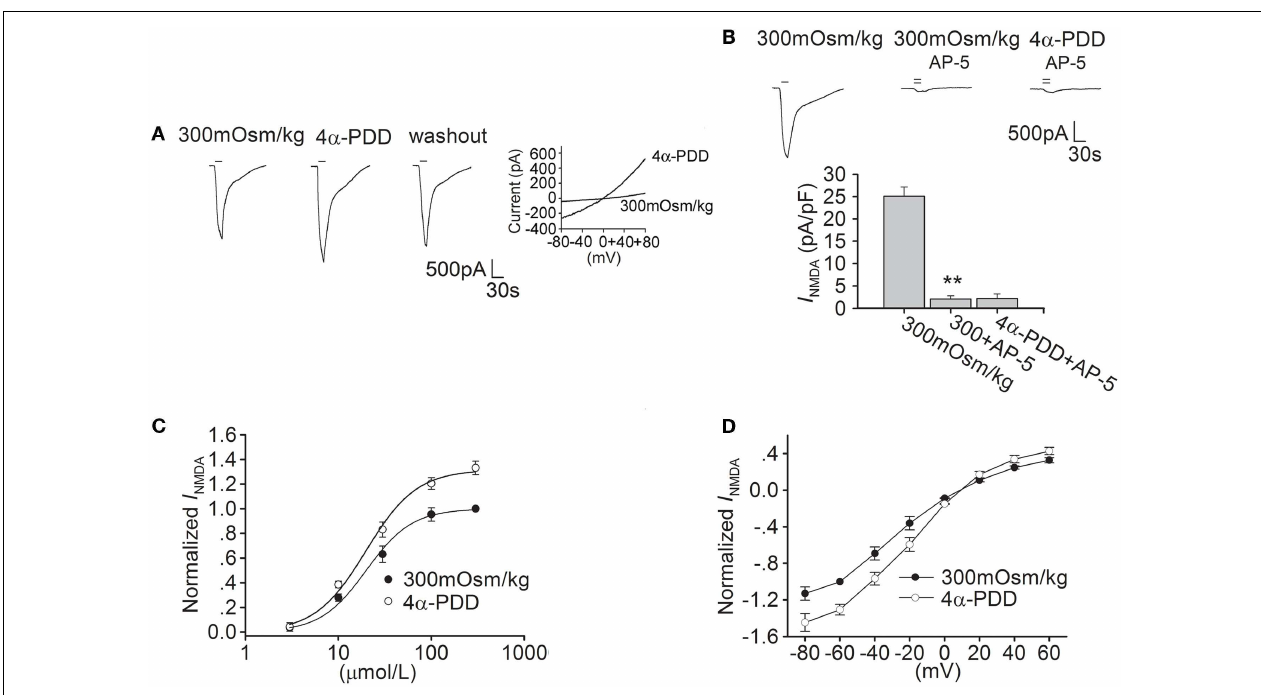
pA/pF by AP-5 ( n = 6, paired t -test, P < 0.01). Note that in the presence of AP-5, the current was not changed by 4 α -PDD. ** P < 0.01 vs. 300mOsm/kg (C) Dose-response curves for I NMDA before and during 4 α -PDD application. Each point represents the normalized current from 6 to 10 neurons. (D) I – V curve was shown in the presence of and absence of 4 α